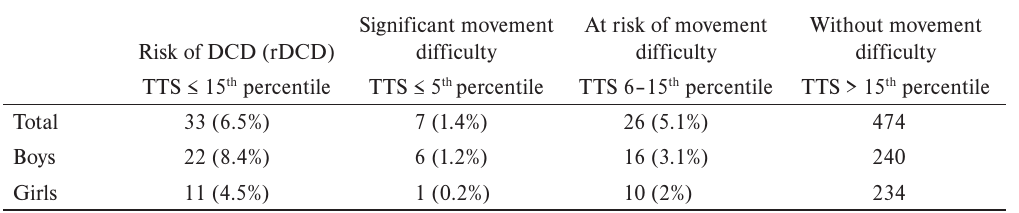
Incidence of movement difficulties according to TTS in MABC-2 in relation to gender